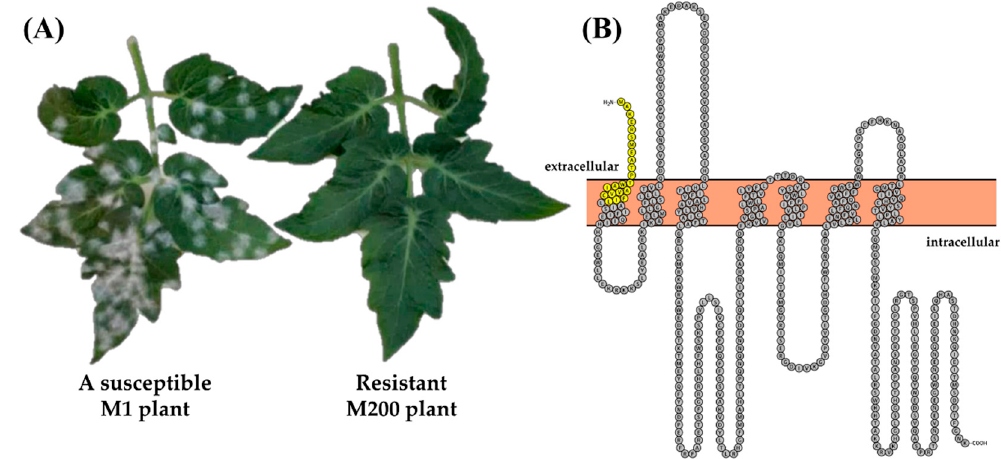
Figure 2. A novel EMS mlo mutant (M200) shows resistance to powdery mildew. ( A ) Contrasting phenotypes of susceptible leaves of an M 1 plant and resistant leaves of the M200 plant after Oidium neolycopersici inoculation. ( B ) Schematic representation of the SlMLO1 protein of the cv. Heinz. The predicted truncated m200 protein is indicated in yellow, while the region that is absent in m200 is indicated in grey.